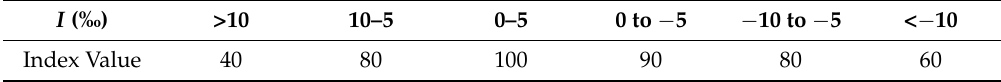
Table 7. Hydraulic gradient (I) suitability evaluation criterion.